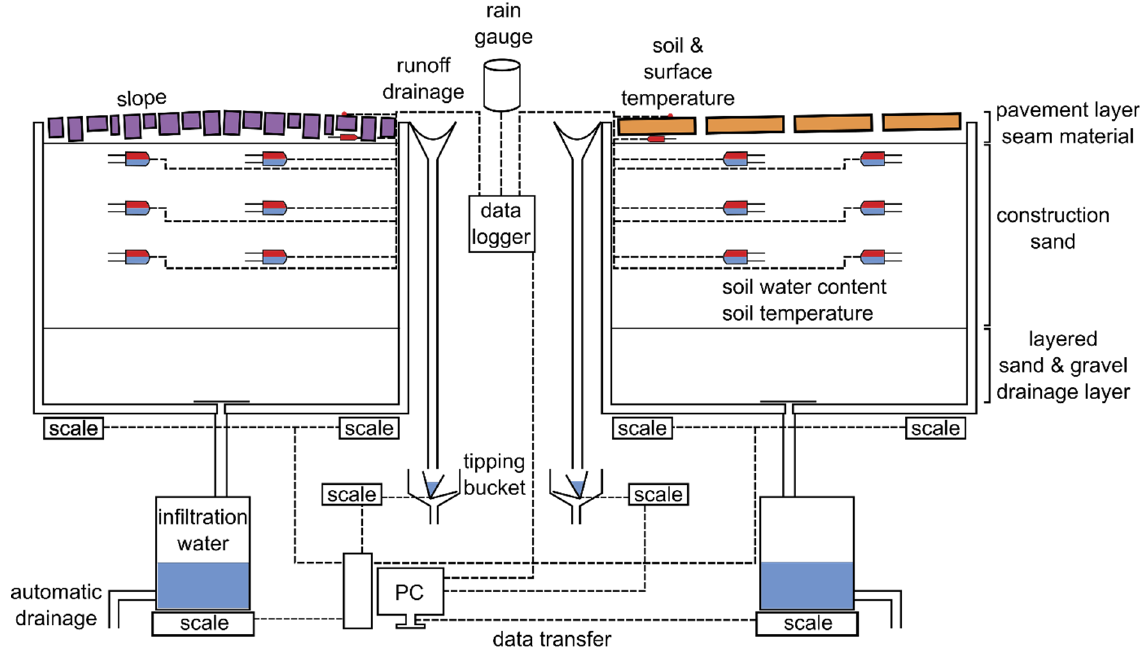
Figure 2. Scheme of lysimeter setup. Reprinted with permission from Timm [22].